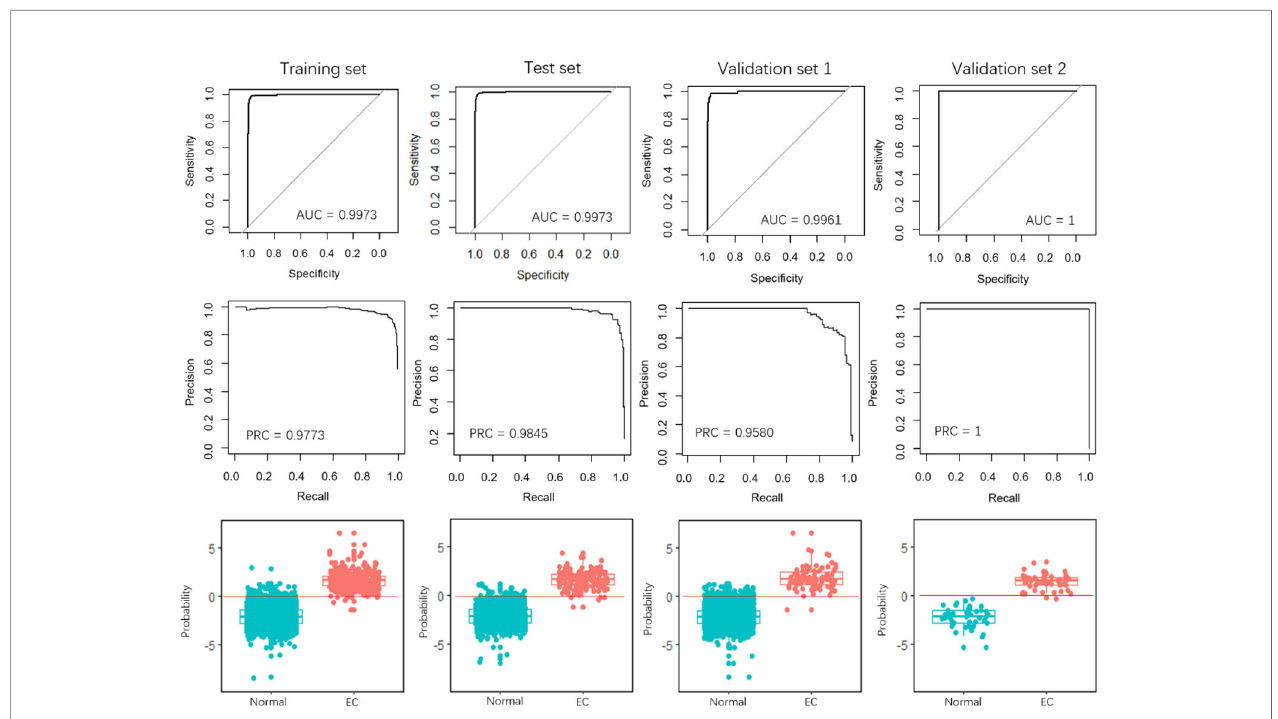
FIGURE 4 | Performance evaluation of the 6-miRNA signature. The fi rst row and the second row show the ROC and PRC curves for the training set, test set, and the two validation sets. The third row illustrates the prediction probability of the EC and normal samples in the four data sets.